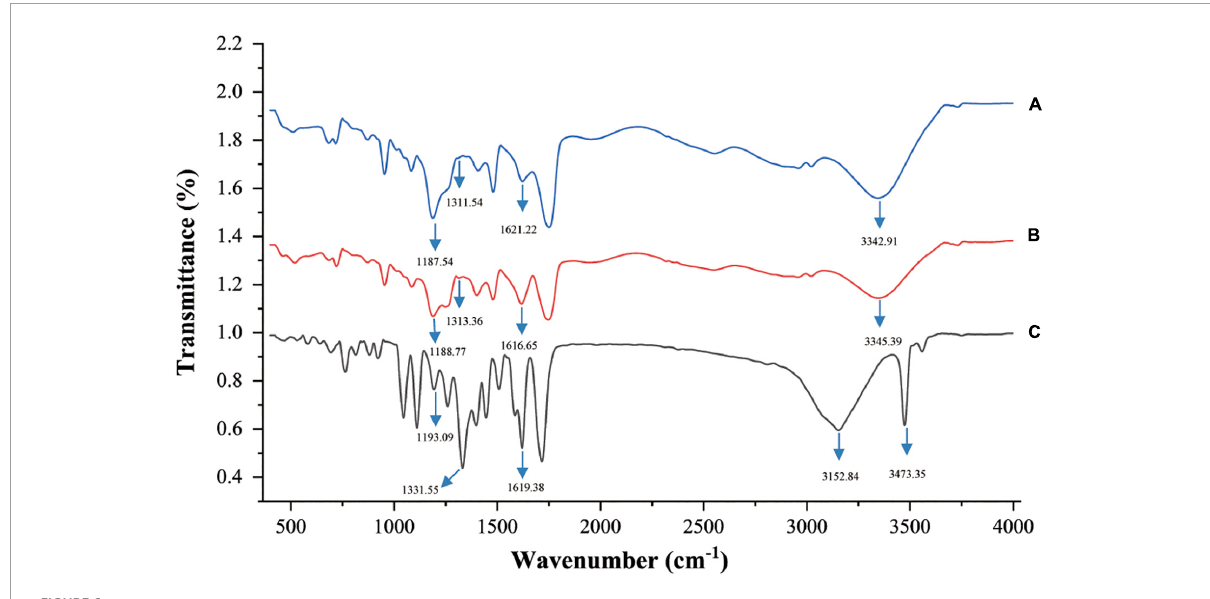
FIGURE6 Fourier transform infrared (FT-IR) spectra of choline chloride-oxalic acid (ChCl:Oa) (A) , EA-ChCl:Oa (B) , and ellagic acid (EA) (C)